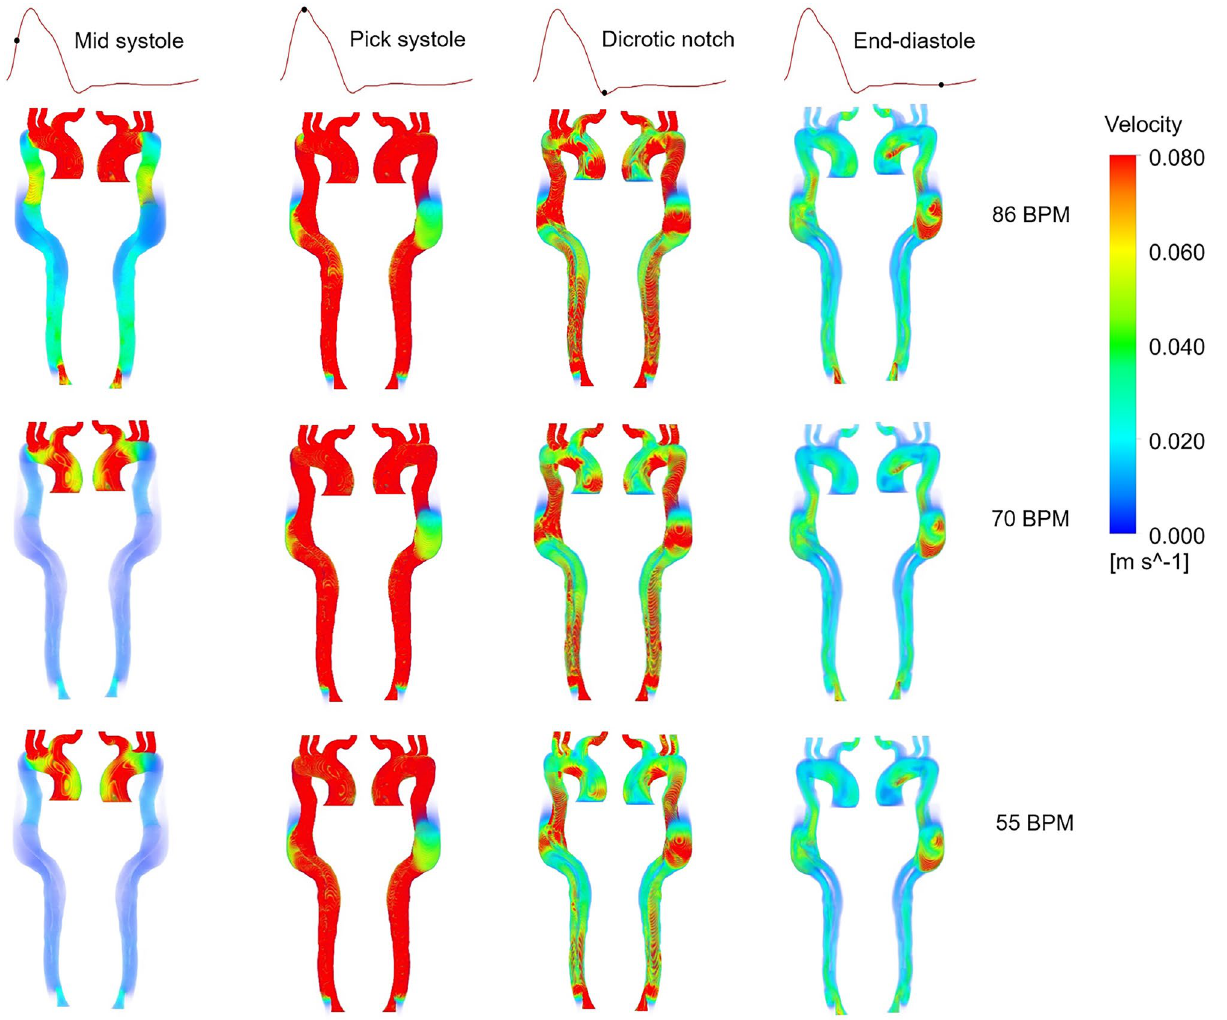
Figure 3. Velocity distribution for all three cases at four cardiac points (the scale bar shown in the figure indicates all